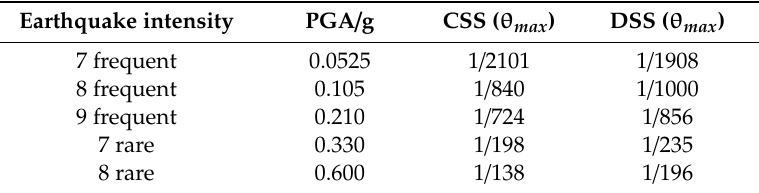
Table 7. Maximum inter-story drift